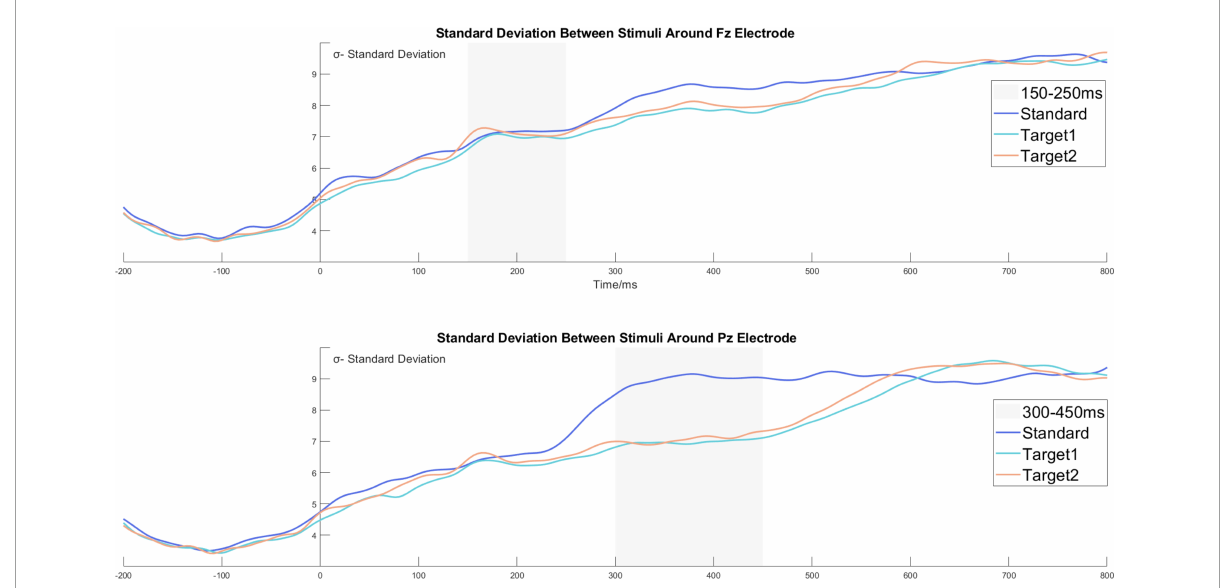
FIGURE6 The standard deviation waves around the Fz and the Pz electrodes. The standard deviation value from a specific time point was calculated by the amplitude from 5080 trials. The standard deviation value represents the degree of dispersion under a particular channel, time point, and